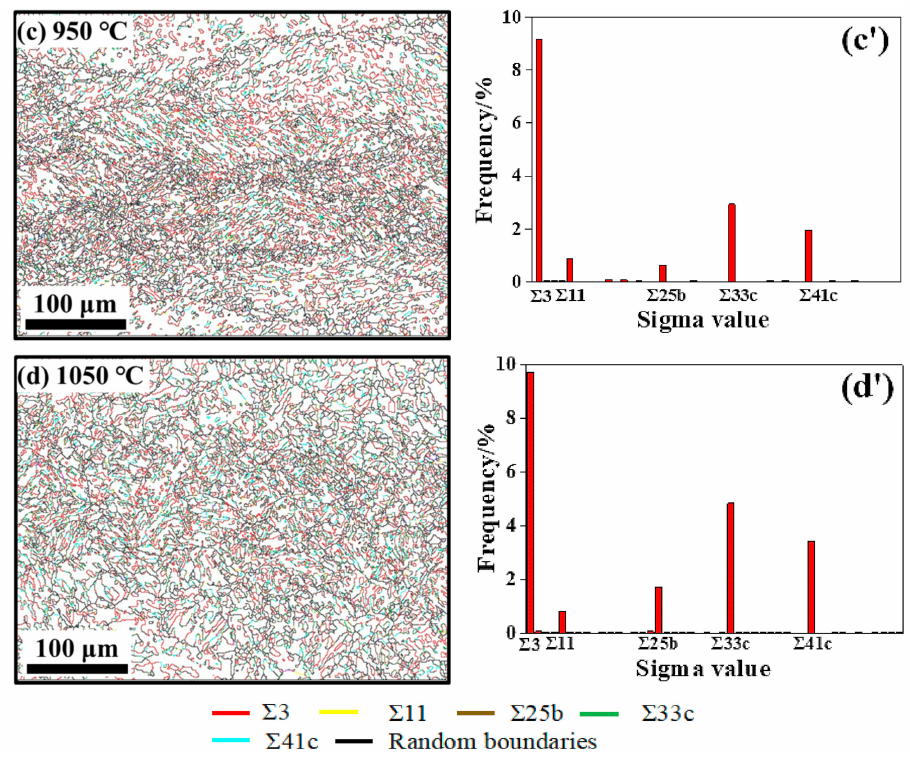
Figure 11. CSL boundary distribution at a strain rate of 0.1 s − 1 and different deformation tempera- tures of 950, 1050 ◦ C: ( a , a (cid:48) , b , b (cid:48) ) without ultrasonic and ( c , c’ , d , d’ ) with